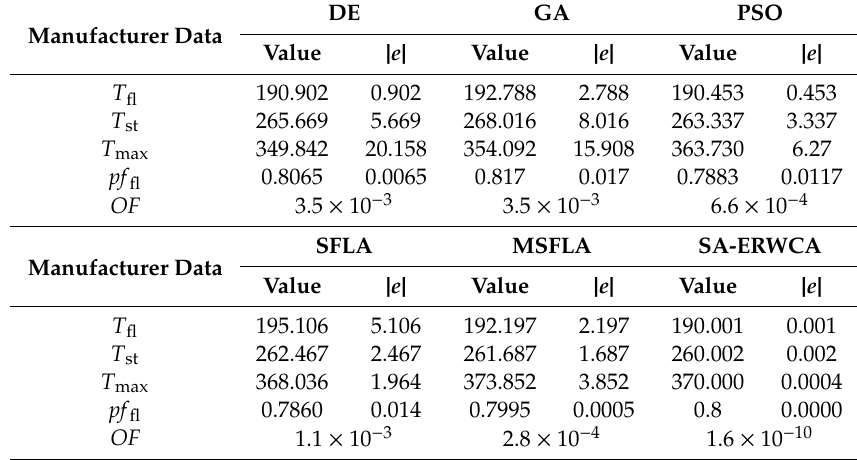
Table 10. Comparisons of